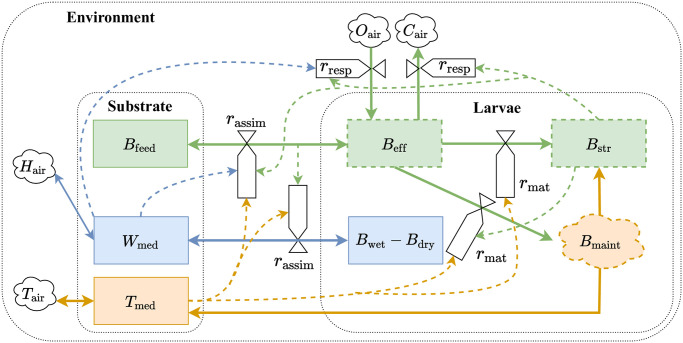
Mass and energy transfer.The flow of mass and energy between the substrate or growing medium, larva body and the environment in response to various states and environment conditions are represented using the valves that regulate this flow. Influence of the states on the rate are indicated using dashed lines. Influence of the states on the rates are not explicitly indicated when the flow takes place between those corresponding states. Valves rassim, rmat, and rresp, represent the assimilation, maturity-maintenance and respiration as a function of various states that influence the flow of biomass and energy.